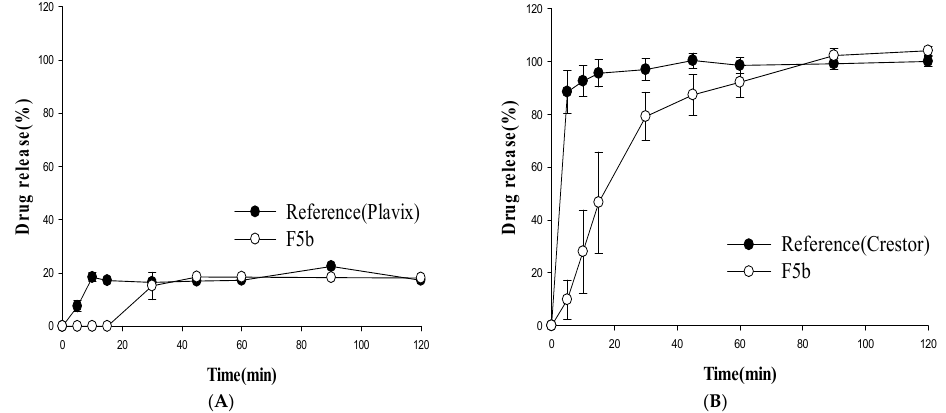
Figure 6. Dissolution profiles of clopidogrel ( A) and rosuvastatin ( B ) from the test (F5b) and reference formulations at pH 6.8 (mean ± SD, n = 4).